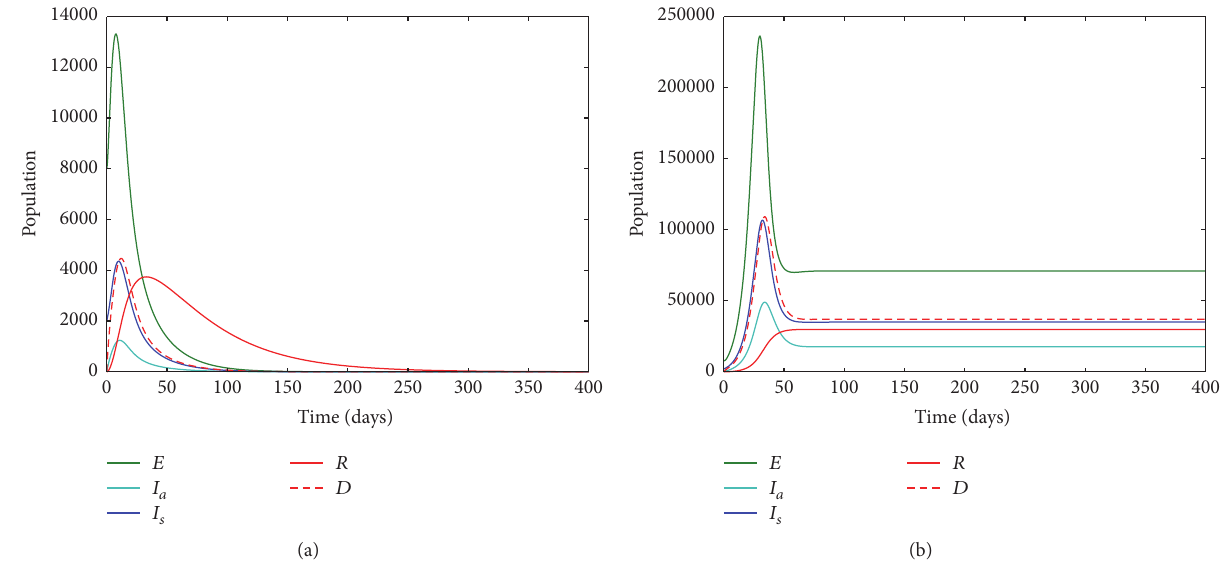
= (2 × 10 −7 ,2 × 10 −9 ) , 2